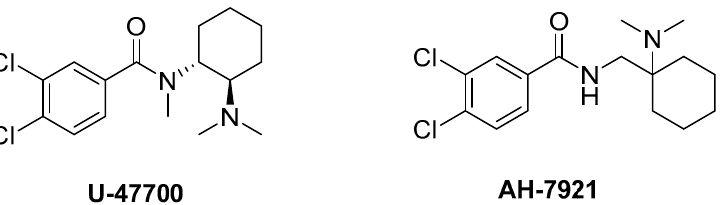
Figure 1. New Synthetic Opioids examined in the present paper.